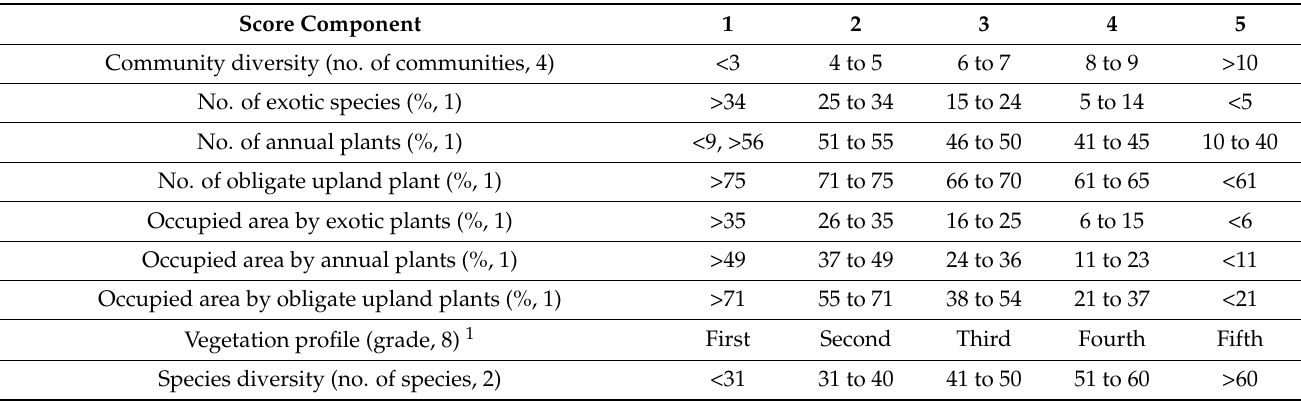
Table 1. Components and scores applied to assess the naturalness of rivers based on riparian vegetation in South Korea. Numbers in parentheses indicate the weighted values.